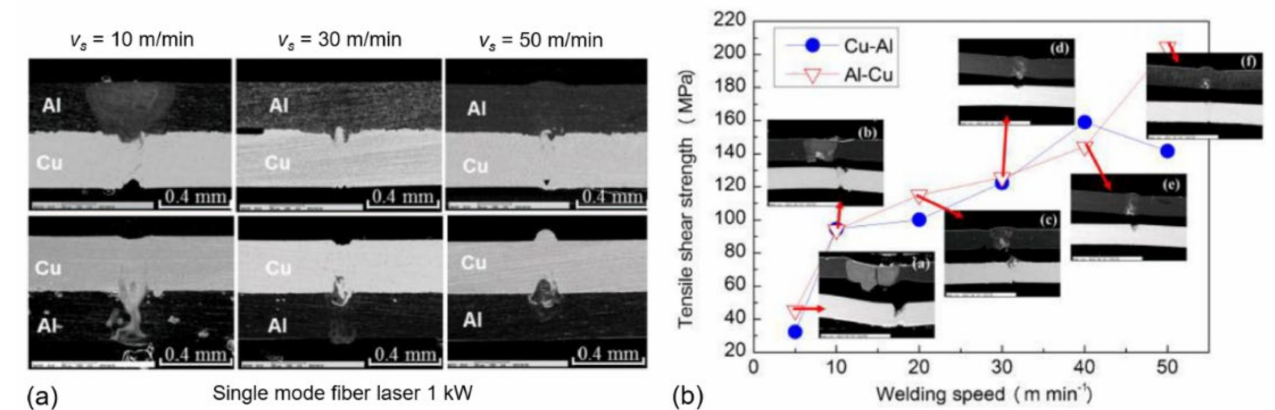
Figure 21. Effect of welding speed ( v s ) and sheet placement on ( a ) quality of weld and ( b ) strength. Based on [164].